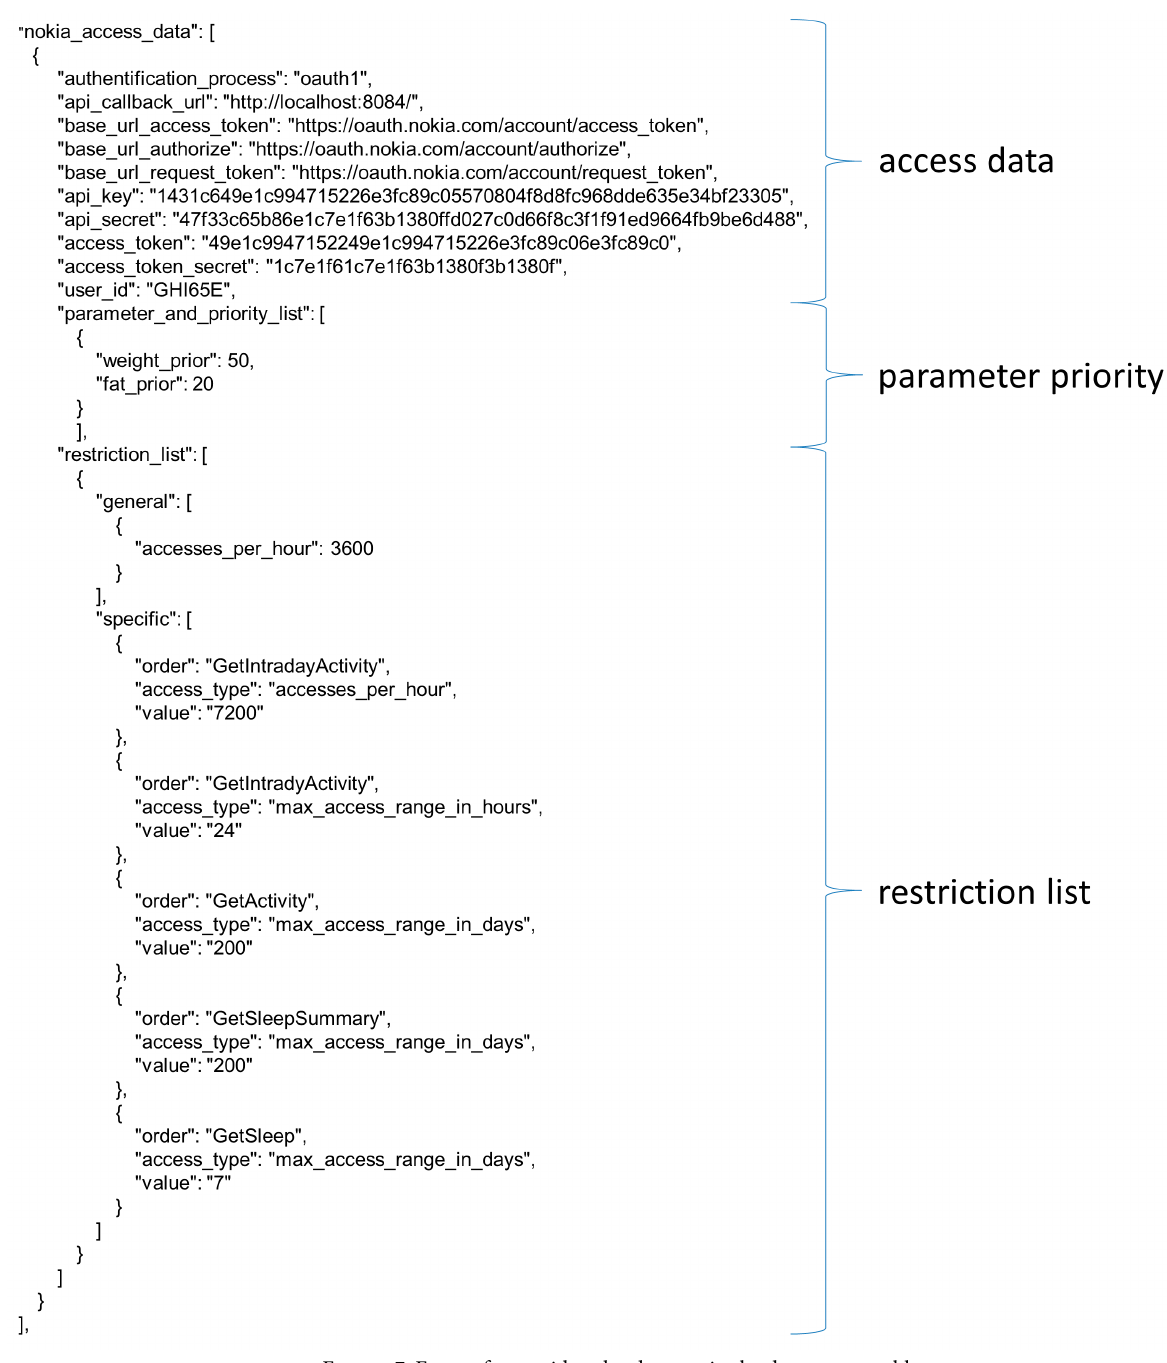
Figure 7: Entry of a provider-cloud server in the data-source